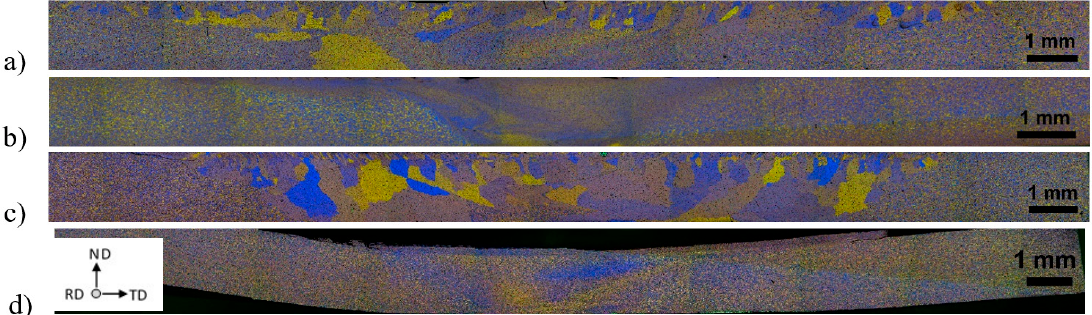
Figure 3. Polarized optical micrograph (POM) Montage of the FSW joint sections of the four experimental conditions of annealing (A), FSW, and CR: ( a ) FSW 1 -A-CR; ( b ) A-FSW 1 -CR; ( c ) FSW 2 -A-CR; and ( d ) A- FSW 2 -CR.